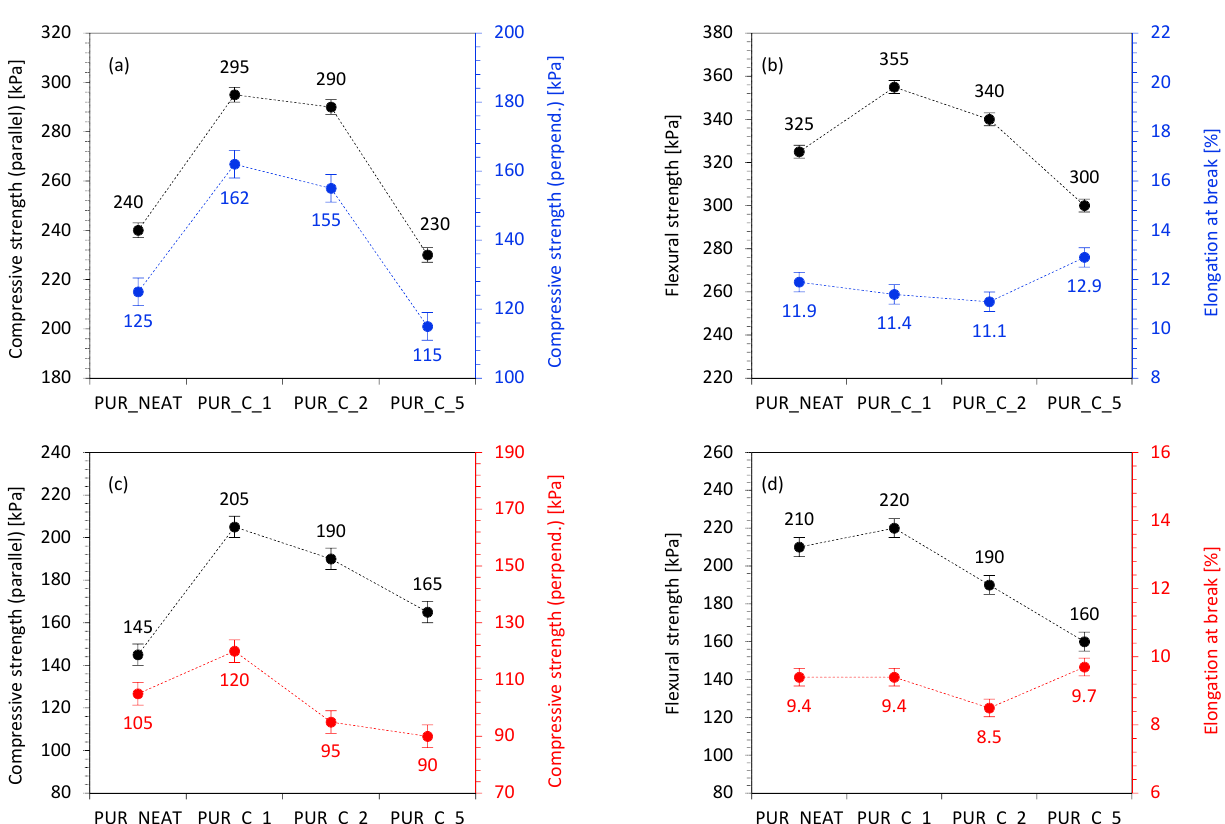
Figure 11. Mechanical performances of PUR composites measured ( a , b ) before, and ( c , d ) after the UV-aging.